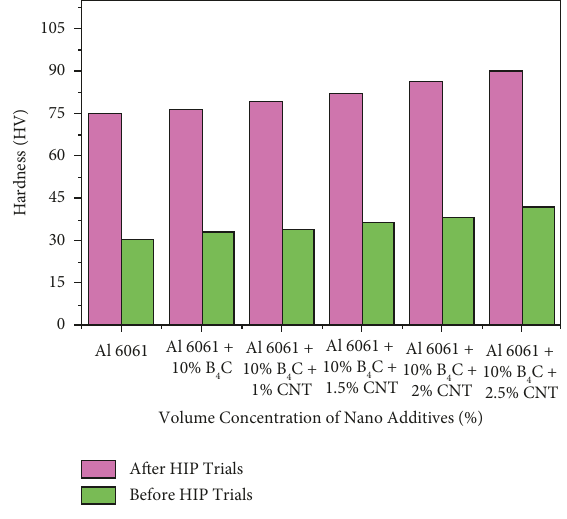
Figure 5: Hardness before and after hot isostatic pressing. Table 3: Pre-HIP and post-HIP compressive stroke of AMC with varied CNT wt %.